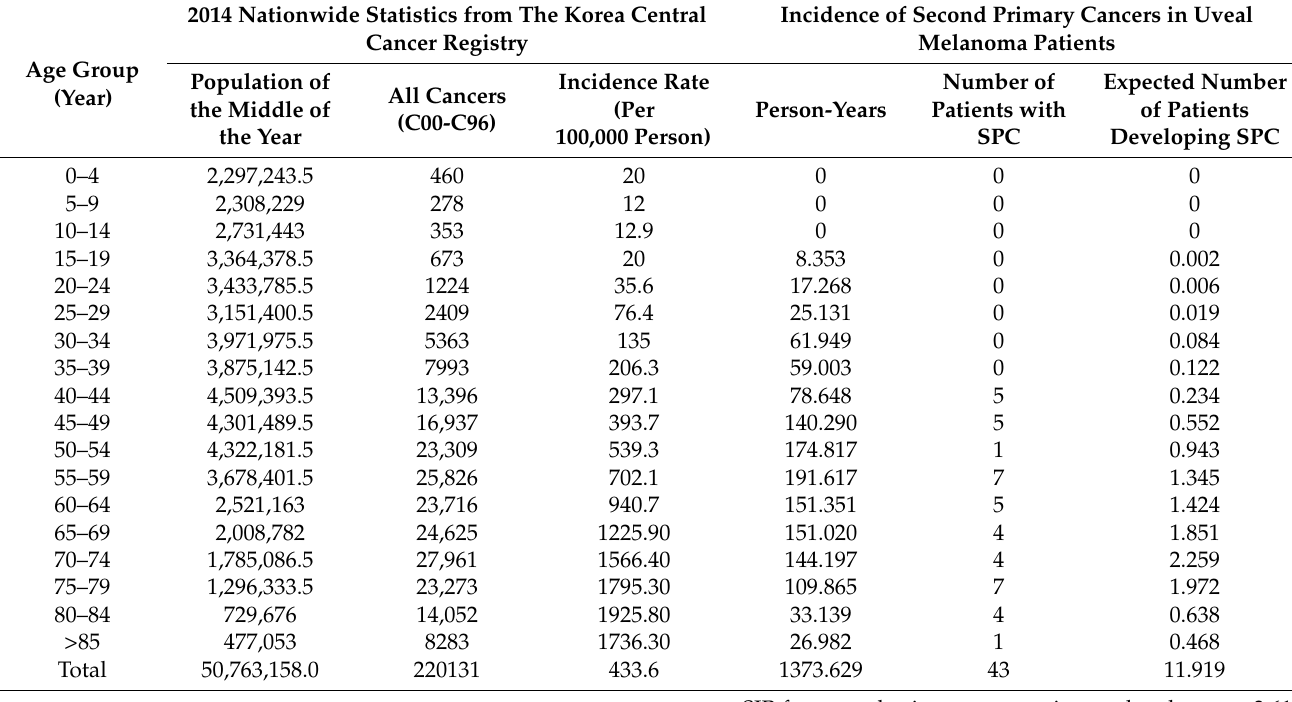
Table 3. Estimation of second primary cancer risk in uveal melanoma patients.